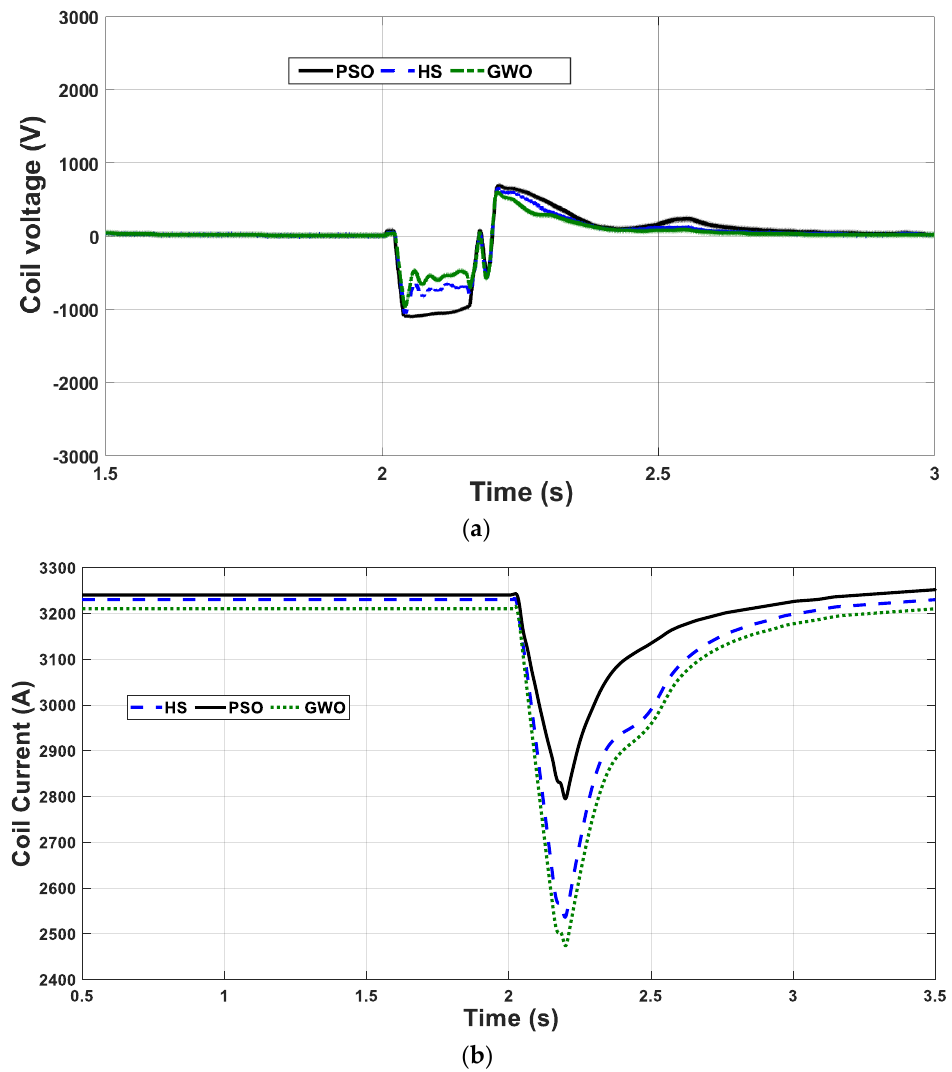
Figure 14. SC performance during the 3-phase fault case study: (a) coil voltage, (b) coil current.